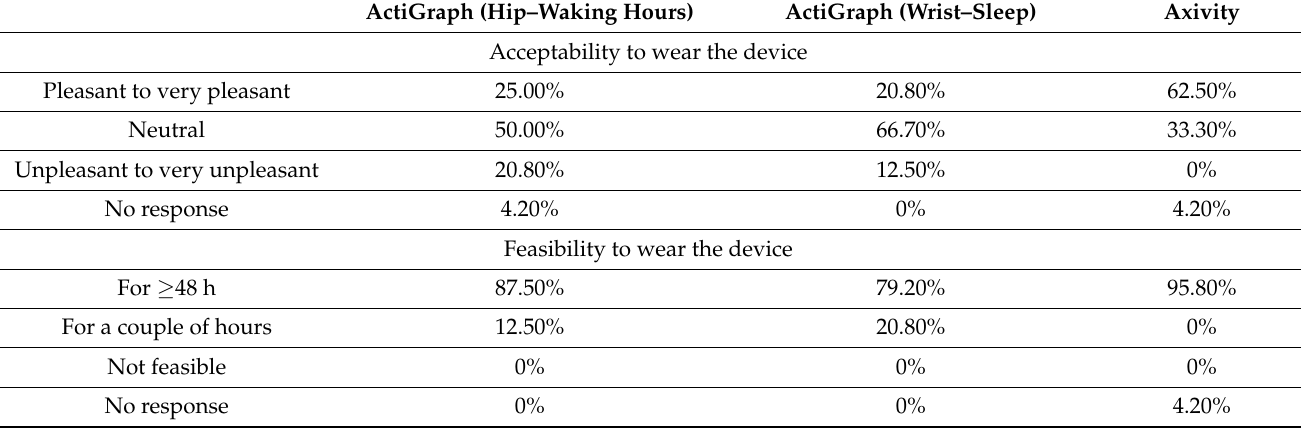
Table 2. Descriptive statistics of adults’ perceived acceptability and feasibility to wear the ActiGraph (on the hip during the day and at the wrist during the night) and the Axivity in the total sample (n =